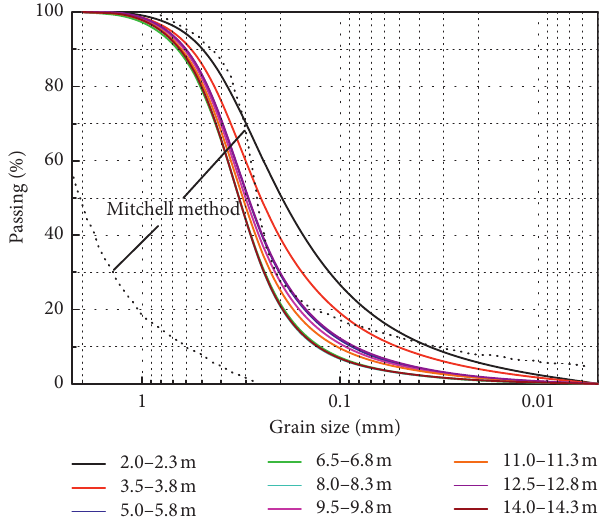
Table 5: Percentage of clay particles in the Xitong expressway.